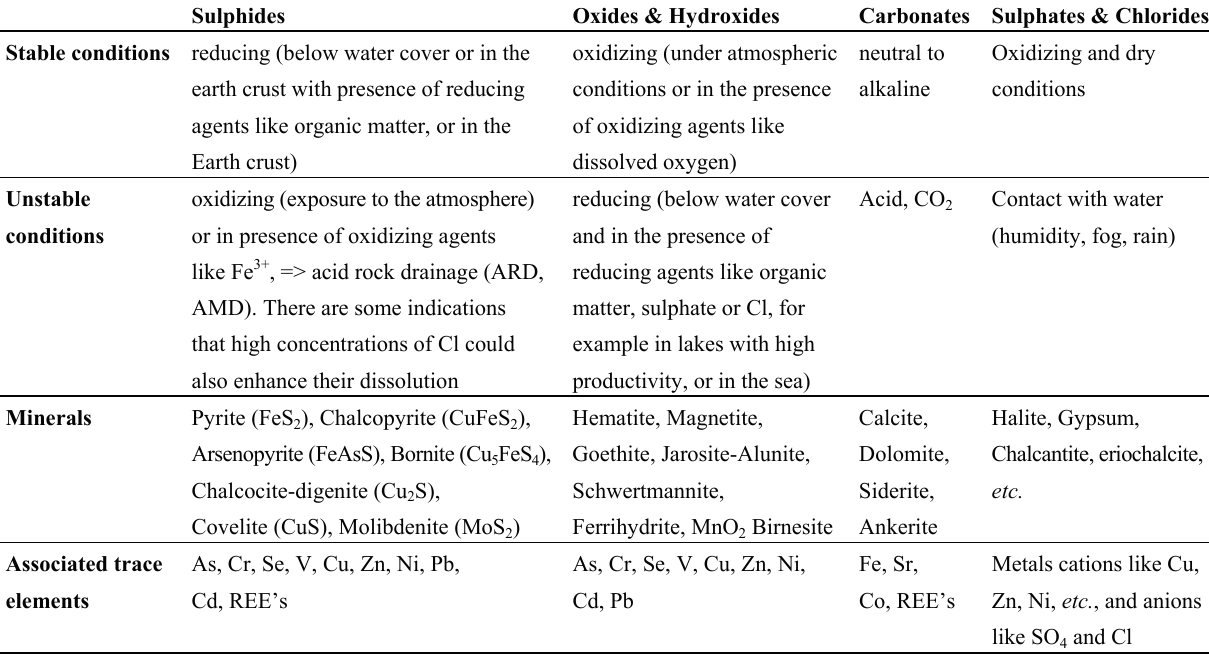
Table 2. Summary of the most reactive mineral groups and their stability in the environment, associated minerals, and trace